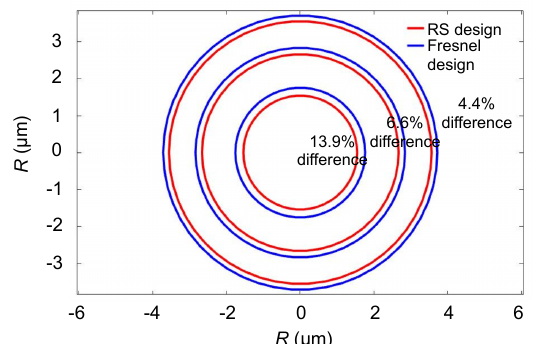
Fig. 2 | Comparison of radii of the two different theoretical flat lens designs.